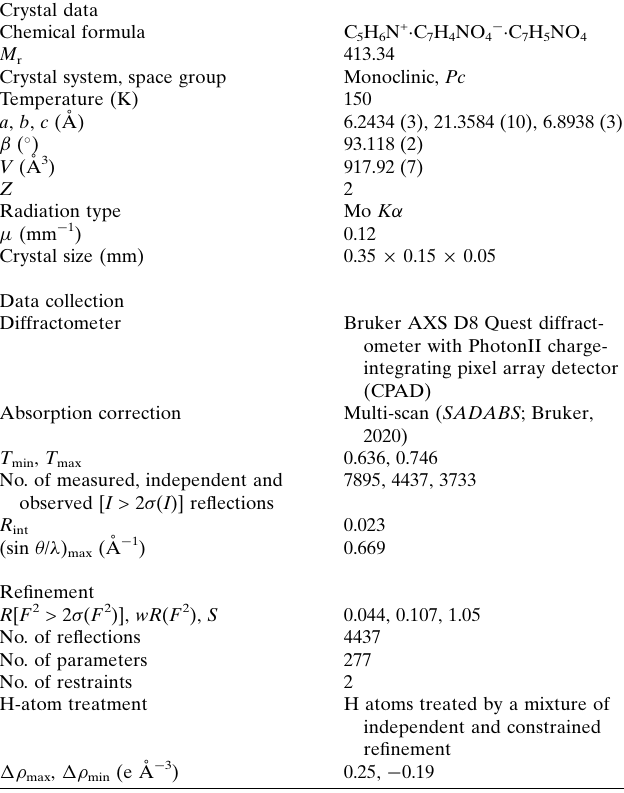
Table 2 Experimental